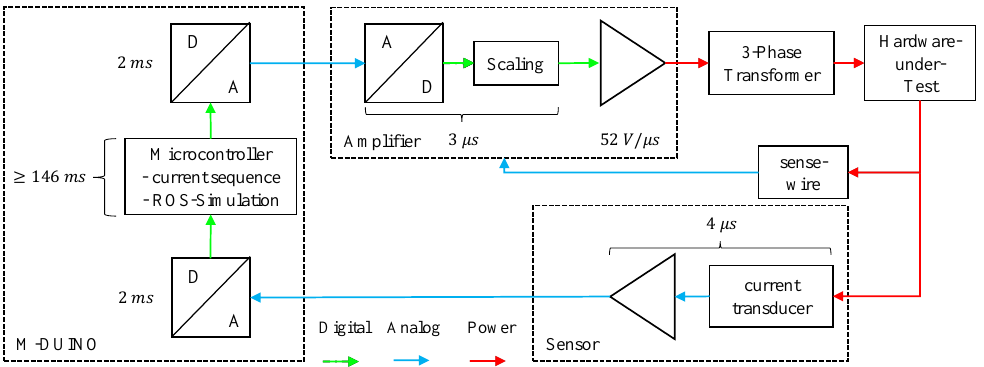
Figure 12. Measurement setup closed-loop control current